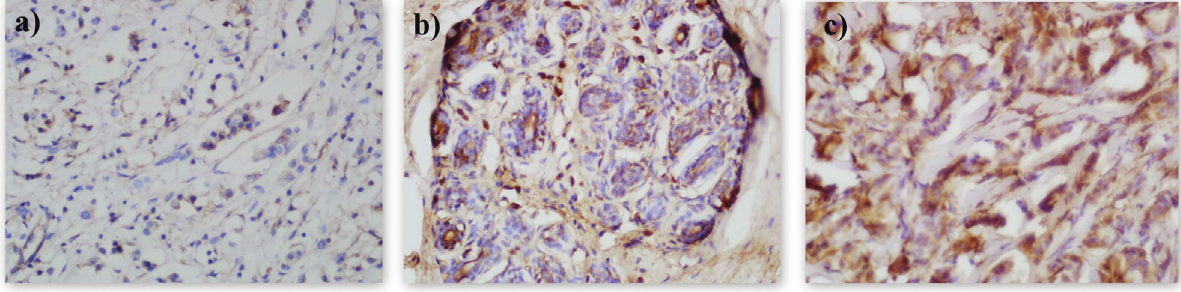
Figure 1 - Immunohistochemical staining for IBFBP5 in breast tissue. (A) Low (+), (B) medium (++) and (C) strong (+++) positive cytoplasmic staining for